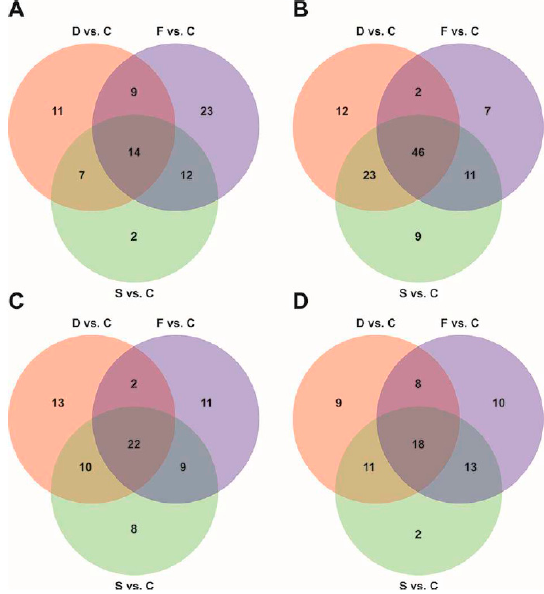
Figure 4. Venn diagrams representing the di ff erentially represented metabolites detected in the root exudates of plants exposed to the di ff erent nutritional conditions. ( A ) Number of up-regulated metabolites detected by GC-MS techniques and normalized on control samples. ( B ) Number of down-regulated metabolites detected by GC-MS techniques and normalized on control samples. ( C ) Number of up-regulated metabolites detected by HPLC-MS techniques and normalized on control samples. ( D ) Number of down-regulated metabolites detected by HPLC-MS techniques and normalized on control samples.